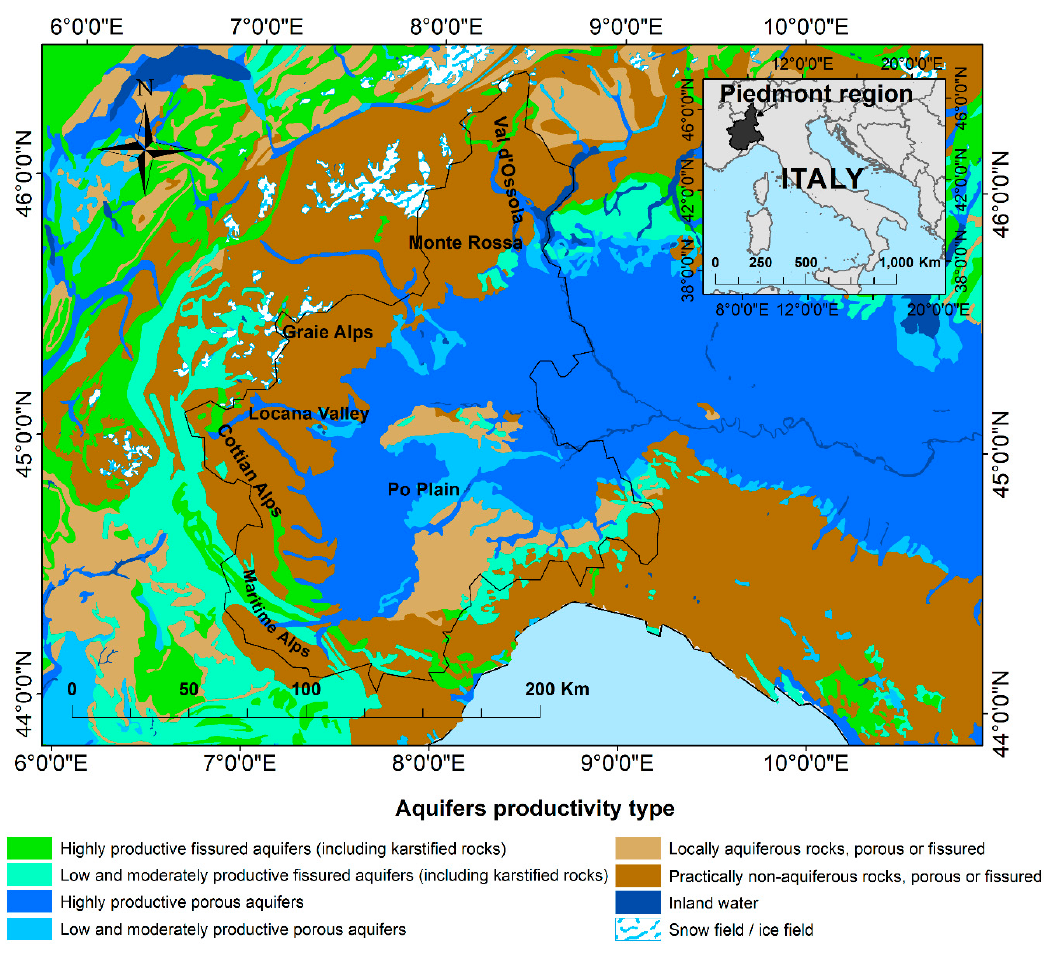
Figure 1. Location of the Piedmont region on the map of Italy and the main aquifers productivity type in the study area.